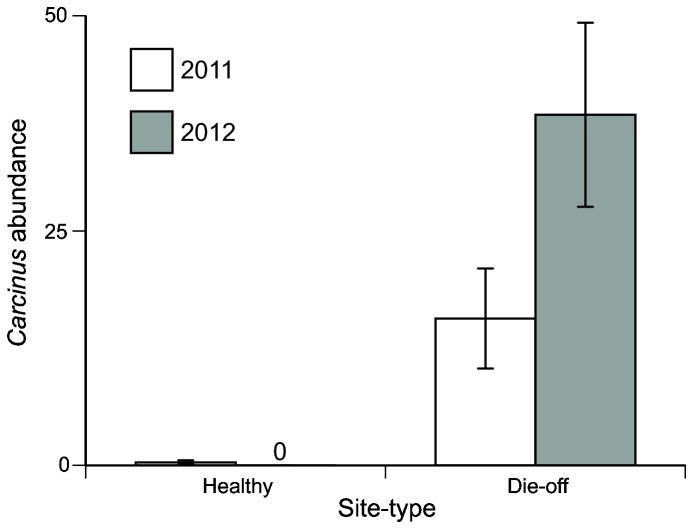
Abundance of intertidal Carcinus per creek banks at healthy and die-off sites between 2011 and 2012.Note not only the magnitude difference in Carcinus densities between site types but also the difference in abundance trends across years. At healthy sites, Carcinus remains low over both 2011 and 2012. At die-off sites, however, Carcinus increases from 2011 to 2012.